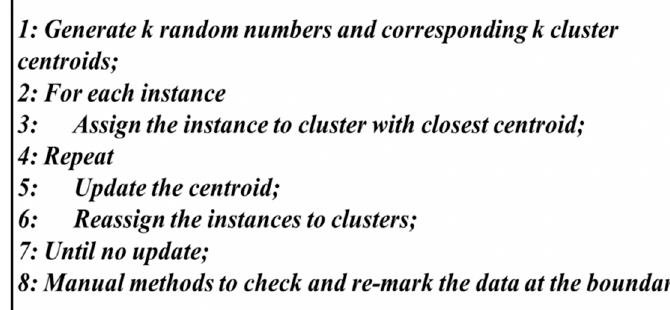
Figure 6. The detailed description of HITL based K-means algorithm.